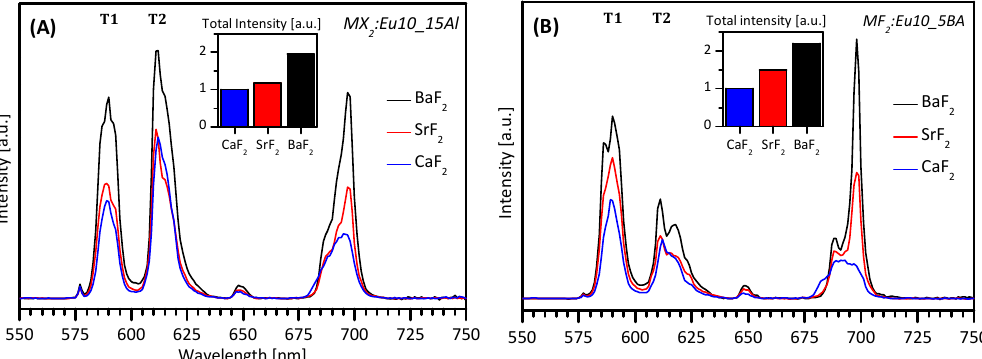
Figure 16. Comparison of the luminescence emission spectra of 0.2 M sols of CaF 2 :Eu10, SrF2:Eu10, and BaF 2 :Eu10 with 15 mol % of aluminium isopropoxide ( A ) or 5 mol % of benzoic acid ( B ) as an additive. T1: 5 D 0 → 7 F 1 , T2: 5 D 0 → 7 F 2 . Reproduced from Reference [58] with the permission of the Royal Chemical Society.